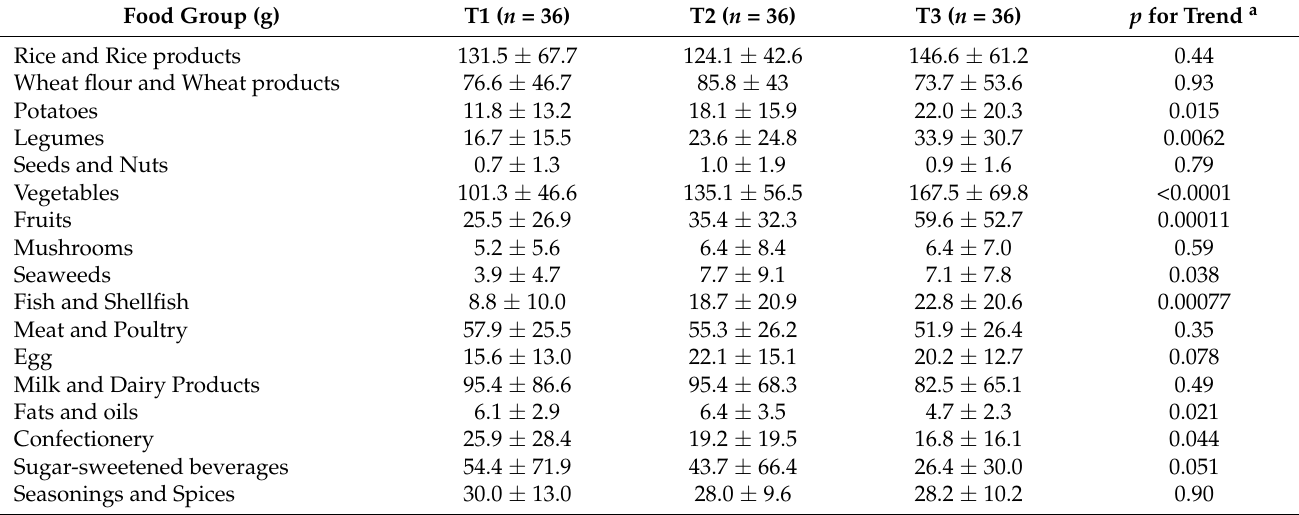
Table 2. Food group intake across the tertile (T) categories of Nutrient-Rich Food Index 9.3 (NRF9.3) score in pregnant women of a birth cohort, BC-GENIST, in Japan.